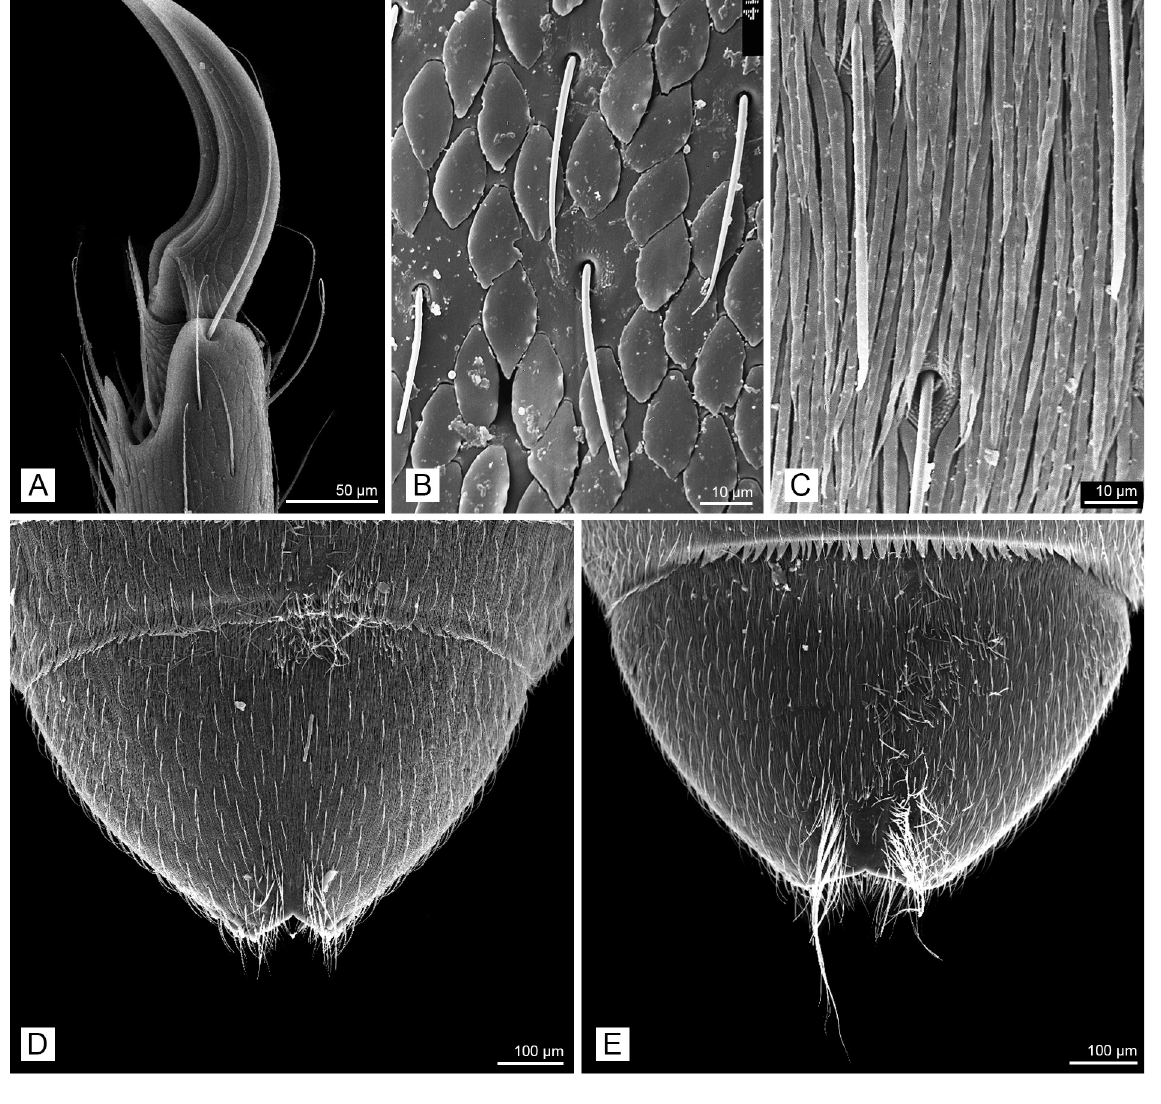
Fig. 7. A–D . Elmomorphus brevicornis Sharp, 1888, ♂ (JKCB). A . Foreclaws. B . Dorsal plastron scales. C . Ventral plastron scales. D . Detail on ventrite 5. E . Elmomorphus amamiensis Nomura, 1959, detail on male ventrite 5